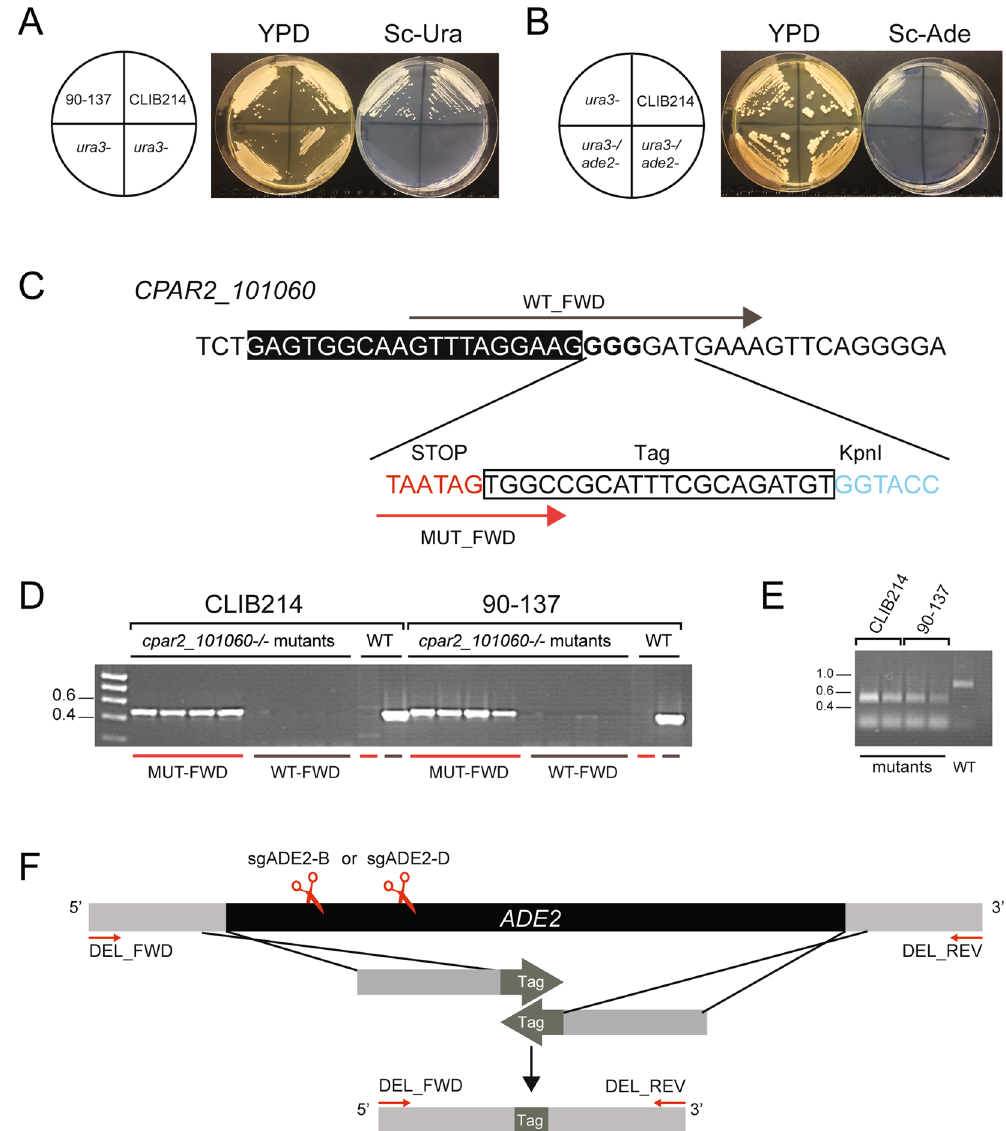
Figure 3. Editing multiple genes in C . parapsilosis . ( A ) The URA3 gene in two strains of C . parapsilosis (CLIB214 and 90–137) was edited using pRIBO-URA3-385 and the relevant repair template (Supplementary Table S1). The figure shows a representative uracil auxotroph from each genetic background. Incorporation of the repair template was confirmed by sequencing. ( B ) The ADE2 gene was edited in one uracil auxotroph of C . parapsilosis CLIB214 (shown in panel A), using pRIBO-ADE2-D, generating strains that are pink on YPD, and fail to grow in the absence of uracil or adenine. Incorporation of the relevant repair template was confirmed by sequencing (Supplementary Fig. S3). ( C ) To edit CPAR2_101060 , a repair template was designed including two stop codons, a unique 20 base pair tag, and a KpnI restriction site. The entire template is 108 base pairs. ( D ) Following transformation of two C . parapsilosis strains (CLIB214 and 90–137) colonies were screened by PCR using one common primer (CP101060_WT-R) and one primer specific for either the wild type (CP101060_WT_F, indicated here as WT-FWD) or the mutant (CP101060_MUT_F, indicated here as MUT- FWD) sequence, shown in brown and red in ( C ). A 458 bp PCR product was amplified from the mutant colonies only when the MUT_FWD primer was used, and from the wildtype (WT) only when the WT_FWD was used. ( E ) An 898 bp fragment was amplified using primers CP101060-F and CP101060_WT_R from two putative CPAR2_101060 disruptants from each C . parapsilosis background, and from wildtype C . parapsilosis CLIB214. Only strains in which CPAR2_101060 was edited were digested with KpnI. ( F ) To completely delete ADE2 , a double stranded break was introduced using either sgADE2-B or sgADE2-D and a repair template including 40 bp from the 5 ′ and 3 ′ flanking regions and a unique 20 bp tag. Deletion mutants were verified by colony PCR using primers (DEL_FWD + REV) flanking the deleted region and this was confirmed by sequencing (Fig.